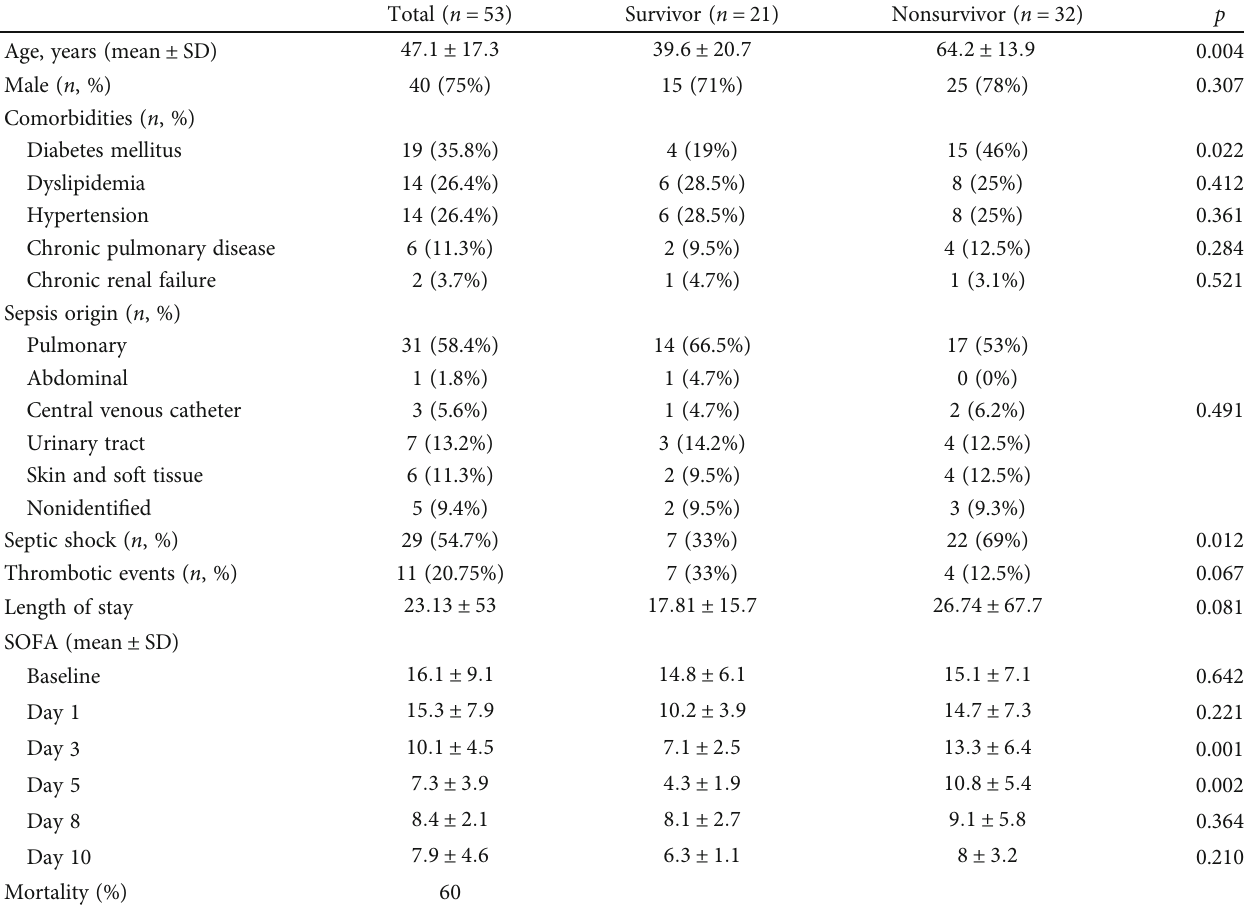
Table 1: Demographic characteristics of the investigated patients.